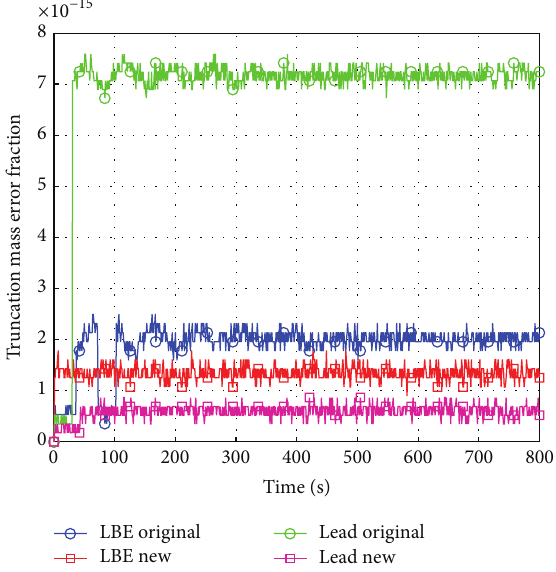
Figure 24: LBE system mass flow rate, original versus new “tpf” file.